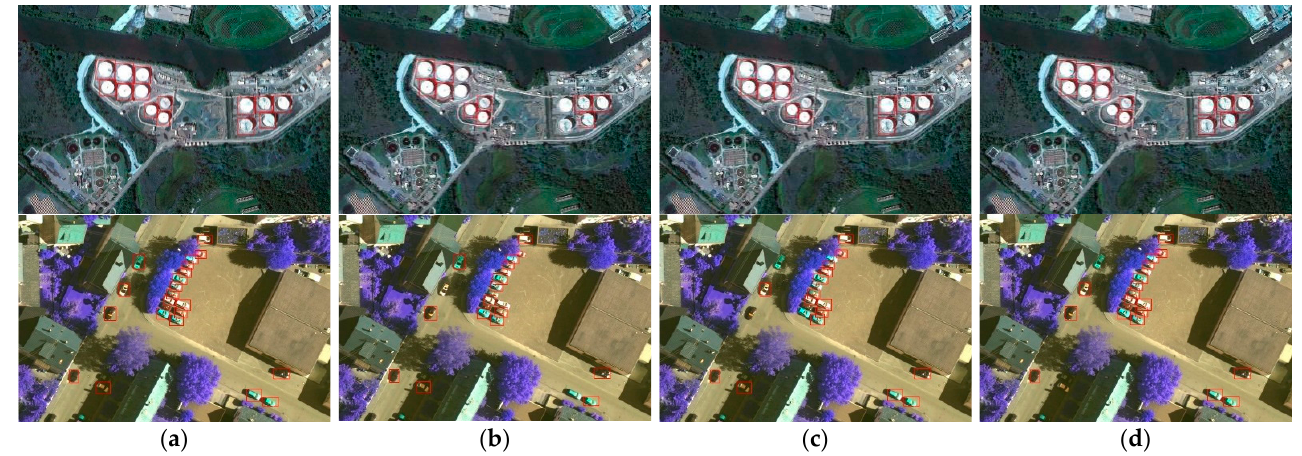
Figure 11. The detection results of different networks for vehicles and storage tanks. ( a ) Multi-stage FEPN; ( b ) Def. Faster-RCNN; ( c ) RICADet; ( d ) Multi-Scale CNN.